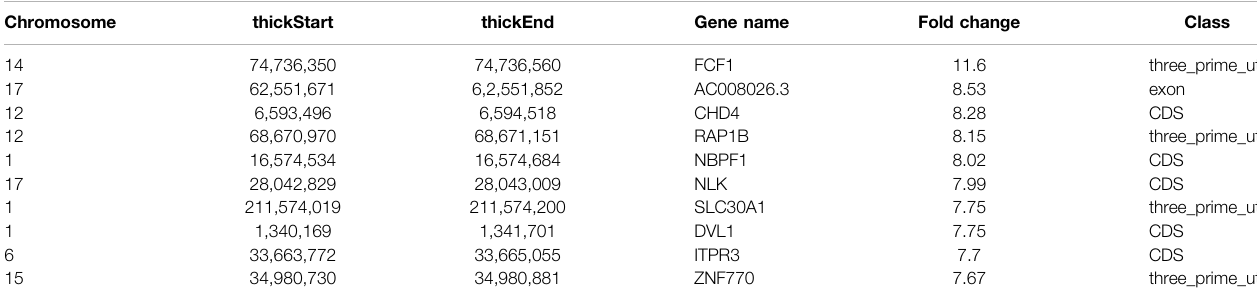
TABLE 5 | Top ten increased methylation